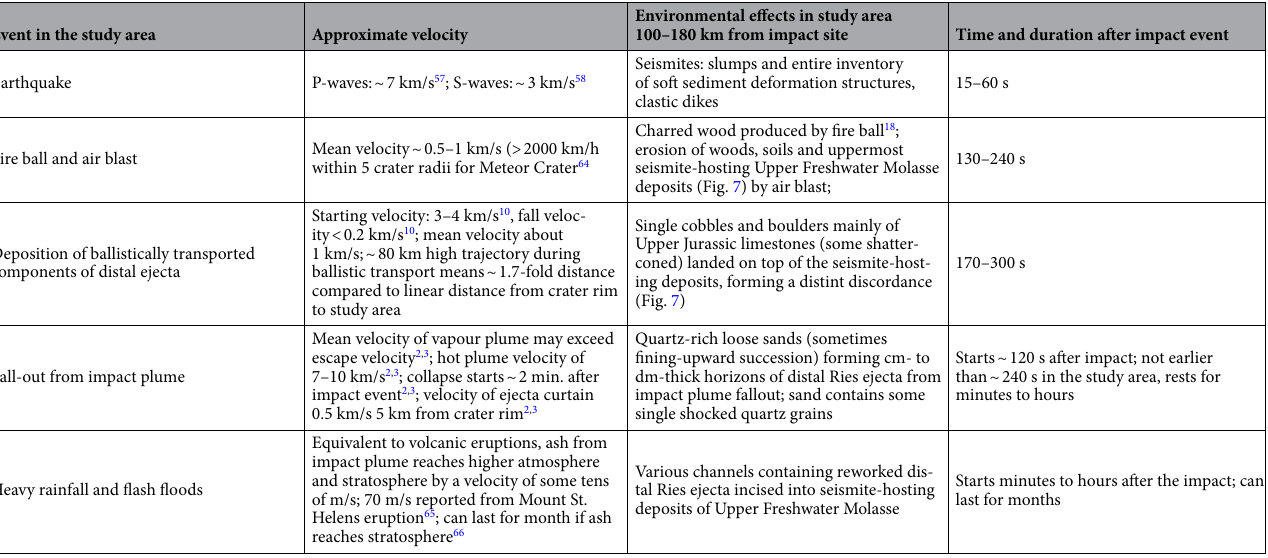
Table 1. List of the environmental effects of the Ries event from seconds to days after impact affecting the wider surroundings of the impact structure as observed in the study area 100 to 180 km from the centre of the